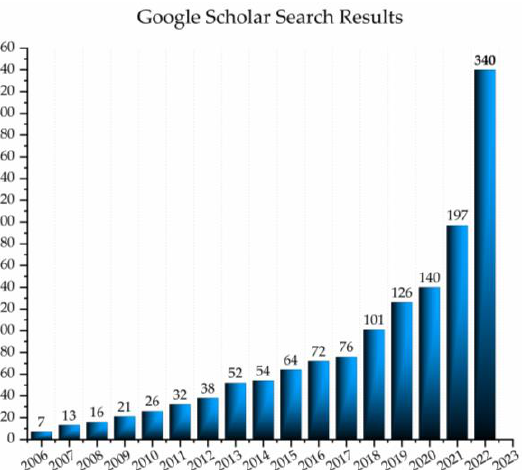
Figure 1. The results of analysis using Google Scholar search tool for articles and patents (excluding citations) mentioning word “aquaphotomics” since its establishment until 2022.